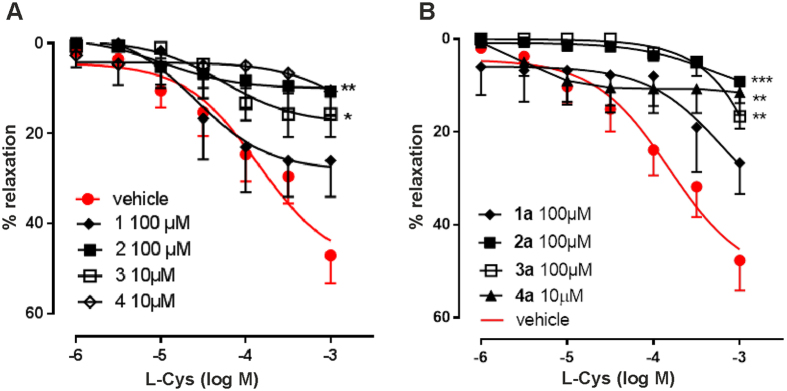
Effect of the various compounds on L-cysteine-induced vasorelaxation.(A) Commercially available compounds (B) Synthesized compounds 1a–3a and 4a. Each group of experiments was carried out on 4 rings harvested from different animals to obtain a more representative averaging. Vehicle, water.